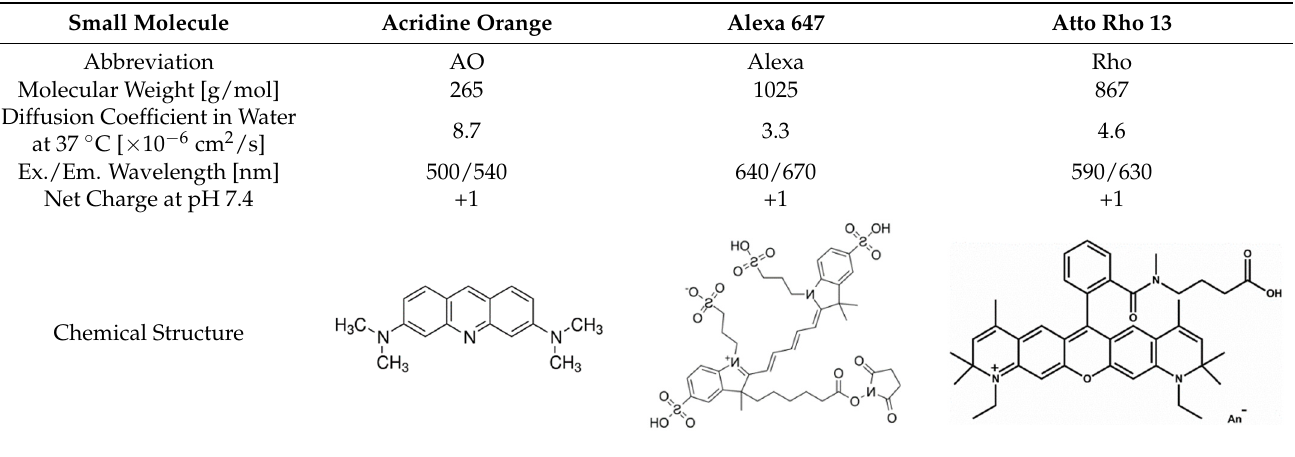
Table 1. Properties of model small molecules used in this study.